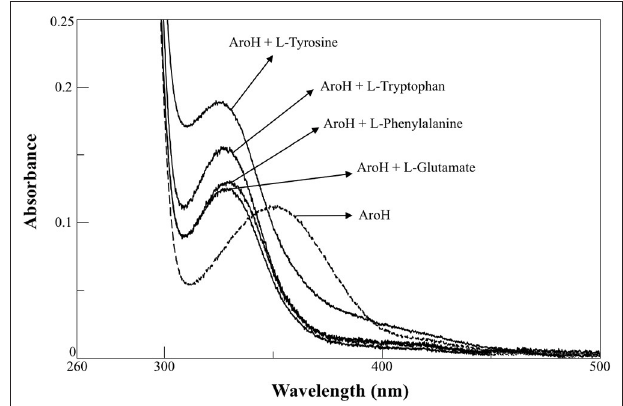
FIGURE 4 | External aldimine of AroH upon binding with different amino donors . AroH (10 µ M) (- - - ) was incubated with 6mM L-tyrosine,